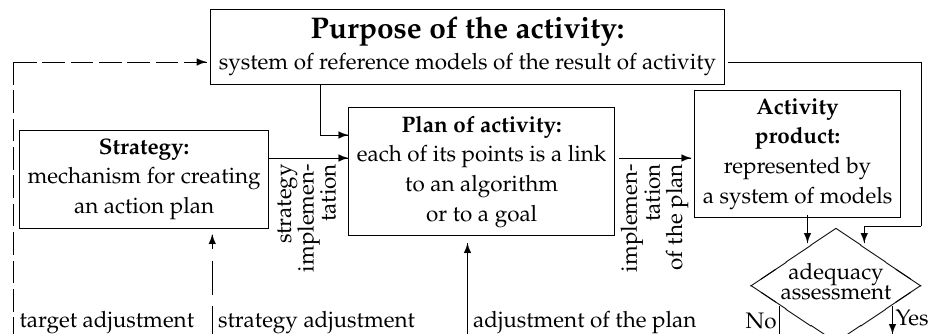
Figure 5. Action plan and strategy. An arrow with “branches” describing the reaction to an inadequate result of the implementation of the plan means that you should first try to change the plan using the old strategy, if this does not help, you should change the strategy, and if this does not bring the desired result, you will have to adjust the goal of the